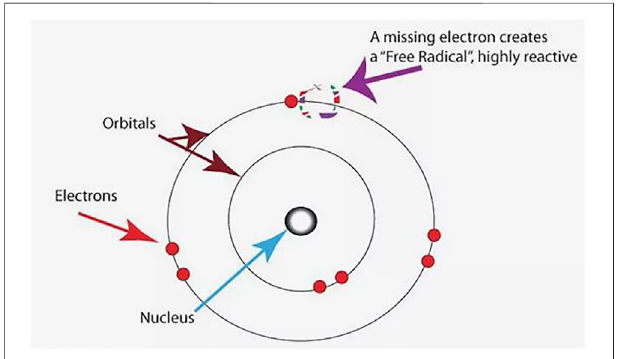
FIGURE 5 | Free radical showing an unpaired electron (Helmenstine,